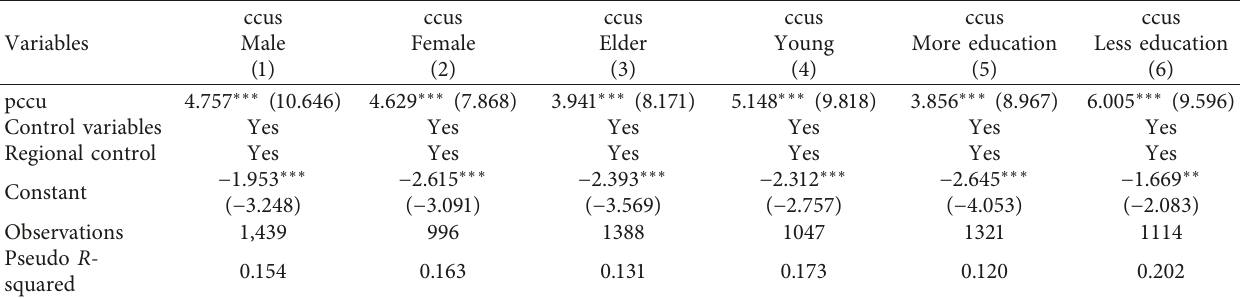
Table 6: Estimation results of the peer effects of family decision-maker’s gender.